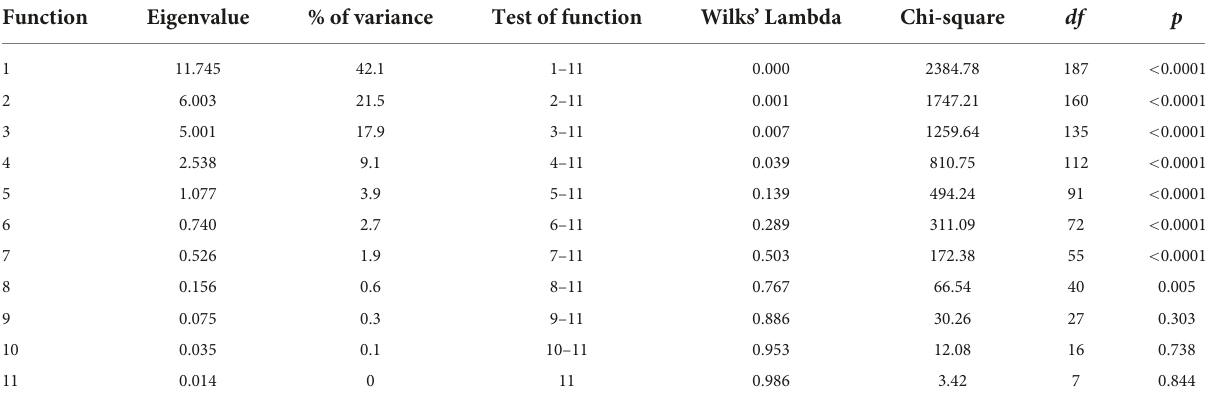
TABLE 2 Assessment of model fit of the discriminant function analyses on social